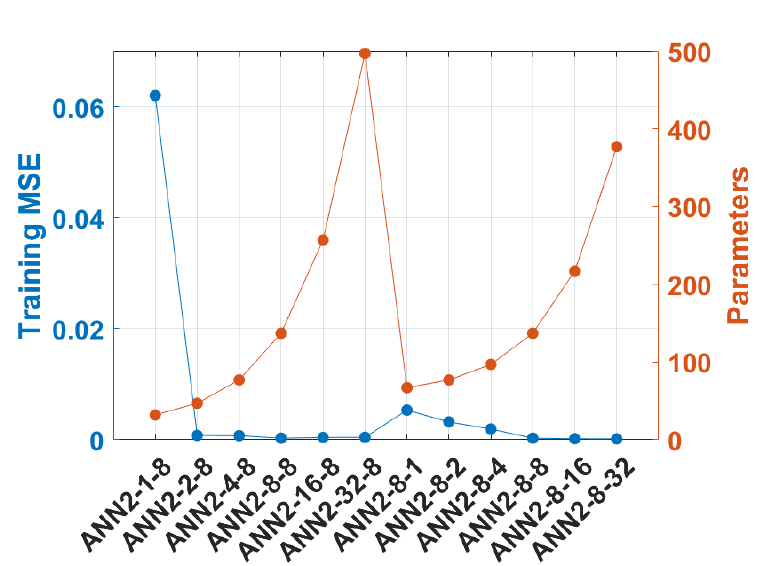
Figure 7. Training results for two-hidden-layer ANNs.